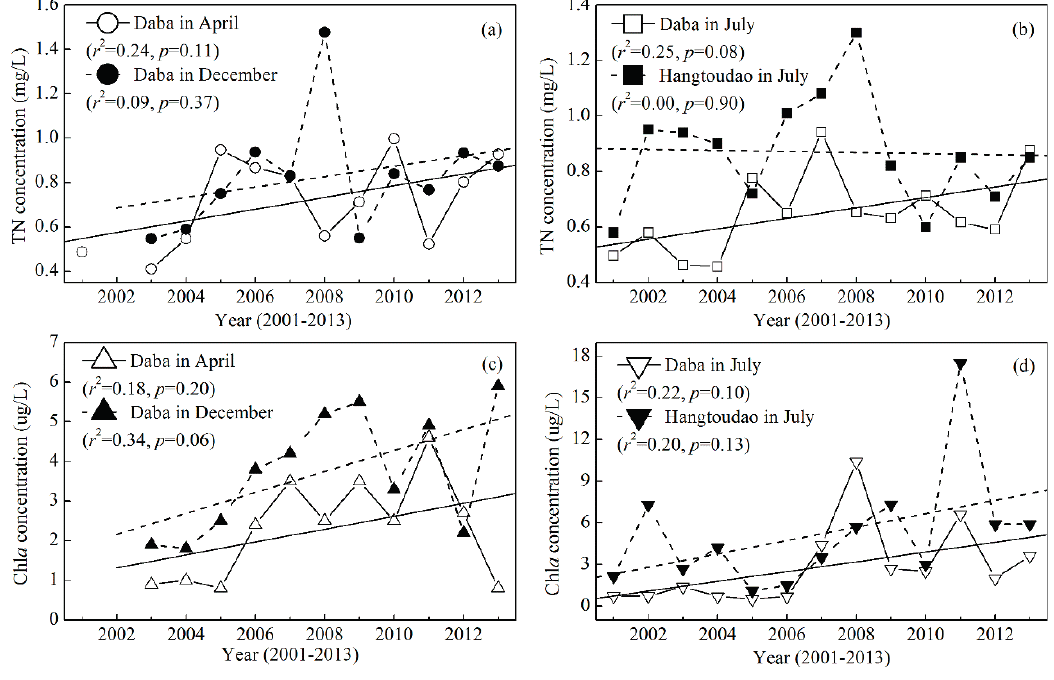
Figure 7. Long-term trends for the total nitrogen ( a ), ( b ) and chlorophyll a ( c ), ( d ) concentrations at Daba in April, July, and December and at Hangtoudao in July in Xin’anjiang Reservoir from 2001 to